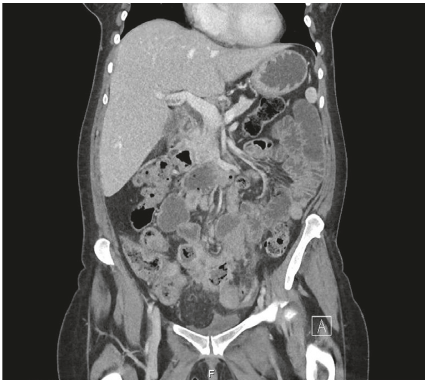
Figure 3: CT scan with unspecific inflammatory